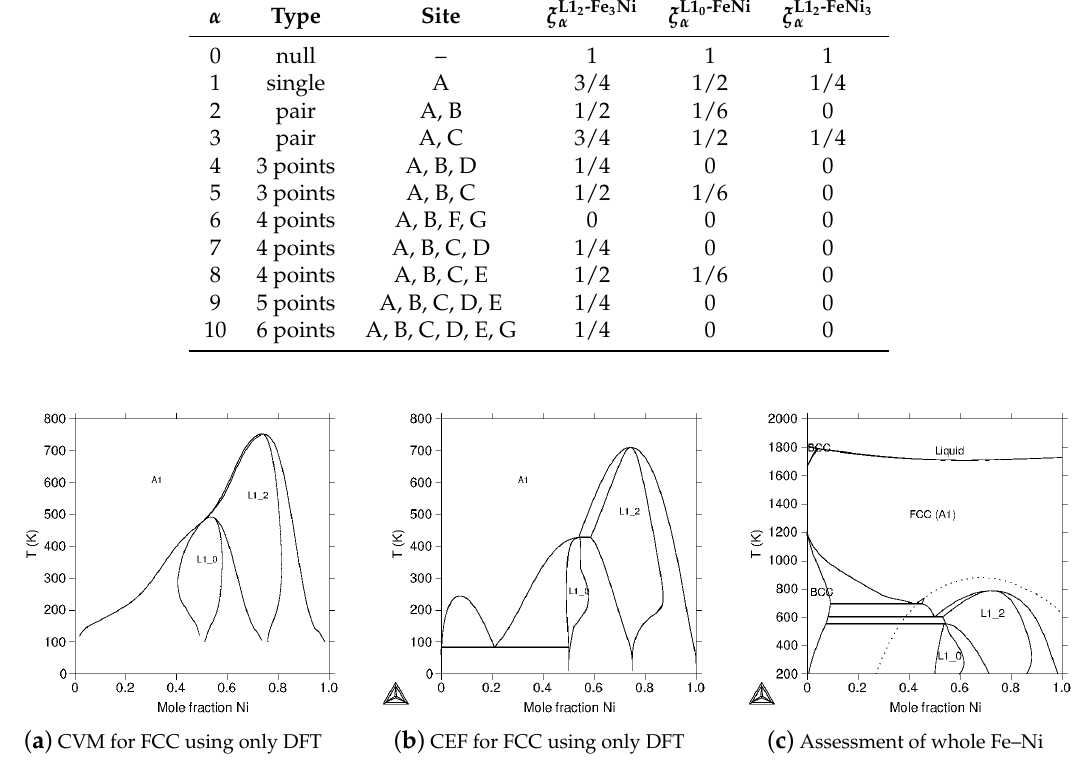
Figure 6. ( a ) The phase diagram calculated with CVM in the TO approximation using effective cluster interactions obtained from the CEM using DFT energy values in Equation (25) and in ( b ) the parameters in Equation (31). In ( c ) the whole Fe–Ni phase diagram calculated from an assessment by Ohnuma et al.